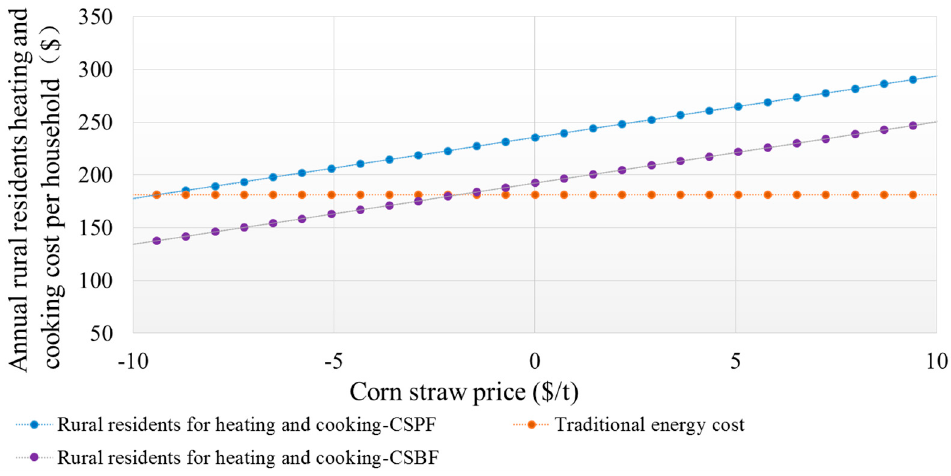
Figure 7. Influence of corn straw price on the economic performance of CSDF for rural residents’ heating and cooking.